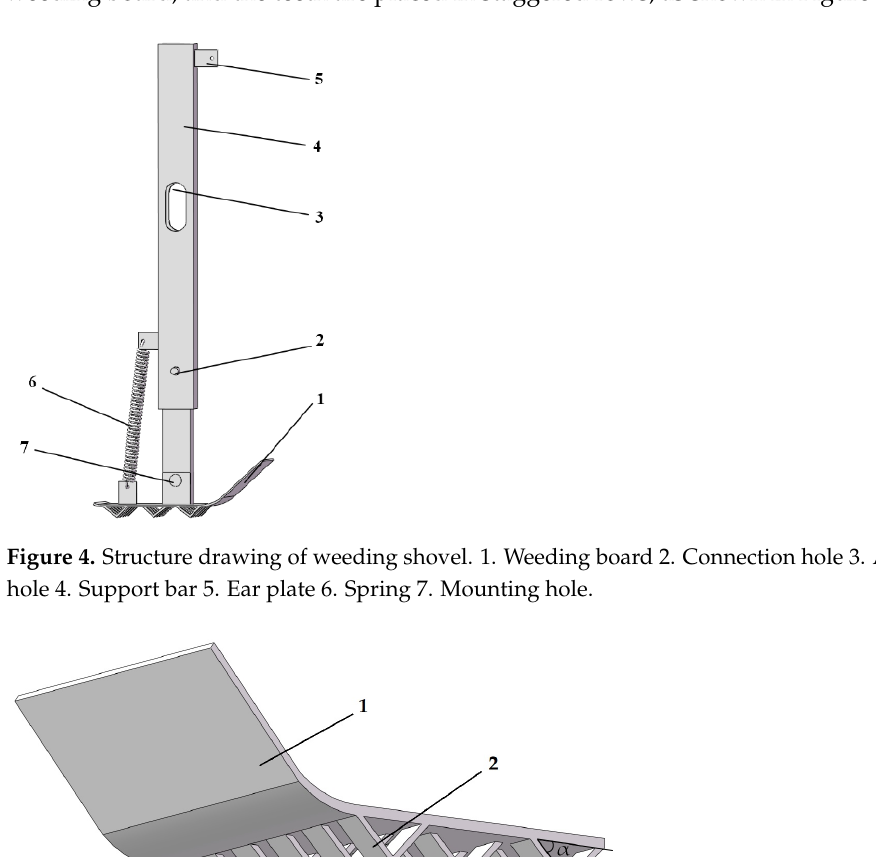
( c ) Figure 6. Movement state diagram of the weeding shovel: ( a ) vertical state, ( b ) forward swing state, ( c ) backward swing state. N is the center of eccentric wheel hub; M is the center of the eccentric contour; I and F are the two vertex positions of the swing rod in the vertical state; E and G are the two vertex positions of the swing rod when the swing rod swings forward to the farthest distance; H and J are the positions of the two vertices of the swing rod when the swing rod swings back to the farthest distance; V and T are the contact points between the eccentric wheel and the support